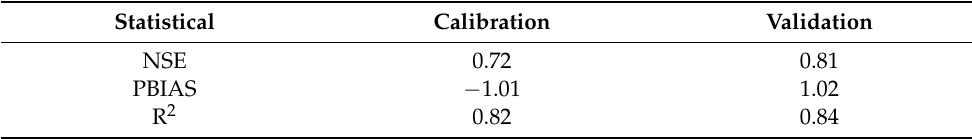
Table 4. Statistical performance of the hydrological model.